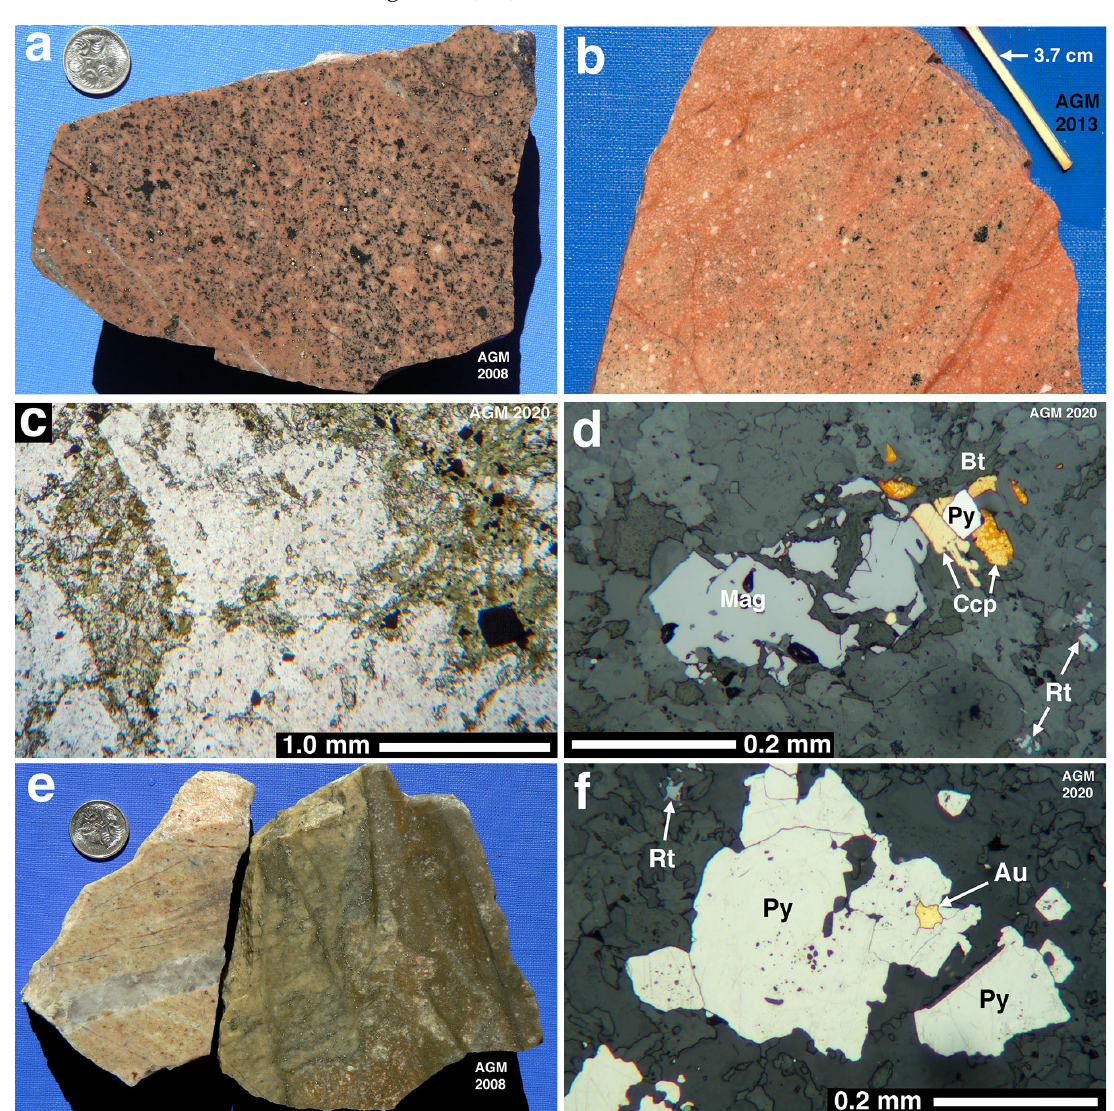
Figure 6. Photographs and photomicrographs of the boudinaged Main Porphyry, samples HB-5 ( a – d ) and HB-6 ( e , f ). ( a ) Early biotite alteration: white plagioclase phenocrysts are embayed by hematite-stained albite + K-feldspar ± quartz. Brown biotite, ankerite, magnetite, and pyrite form aggregates. The coin is 19 mm across. ( b ) Late sericite-hematite-pyrite alteration: white plagioclase phenocrysts are embayed by pink albite + K-feldspar ± quartz. In the red selvages of fractures, biotite is replaced by phengite + chlorite ± rutile and magnetite by pyrite. ( c ) Early biotite alteration: biotite + ankerite after rhomb-shaped hornblende adjacent to xenomorph biotite-ankerite and opaque magnetite-pyrite in an alkali feldspar groundmass. Plane polarized light. ( d ) Early biotite alteration: magnetite (Mag) in contact with biotite (Bt), chalcopyrite (Ccp), and pyrite (Py) adjacent to rutile (Rt). Plane polarized light reflected in air. ( e ) Late alteration. RIGHT: sericitic replacement, crackle fractures control phengite + pyrite in albite + dolomite + quartz. LEFT: albite-quartz-dolomite replacement centered on a quartz ± albite ± tourmaline vein. The coin is 19 mm across. ( f ) Late sericitic alteration: native gold (Au) enclosed in pyrite (Py) adjacent to rutile (Rt). Plane polarized light reflected in air.